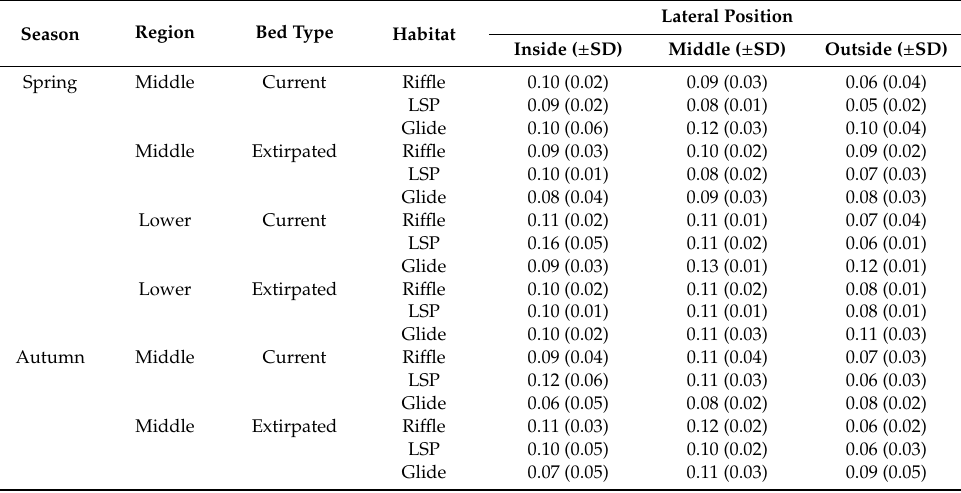
Table A3. Pooled mean cell Froude numbers ( ± SD) by lateral position (Inside, Middle, Outside) across seasons (Spring, Autumn, Winter), regions (Middle, Lower), bed type (Current, Extirpated), and habitat (Ri ffl e, LSP,